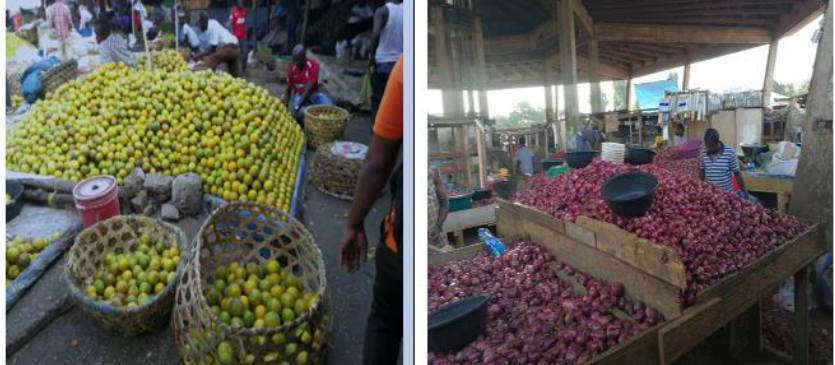
Figure 3: Graded and Sorted Oranges and